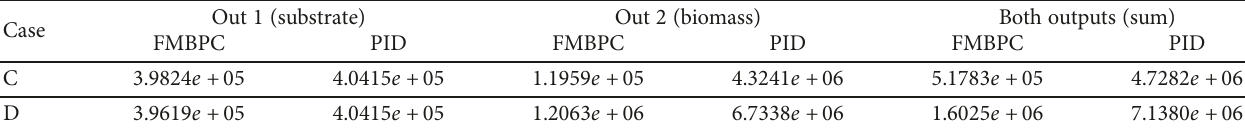
Table 11: Performance evaluation by the ISE